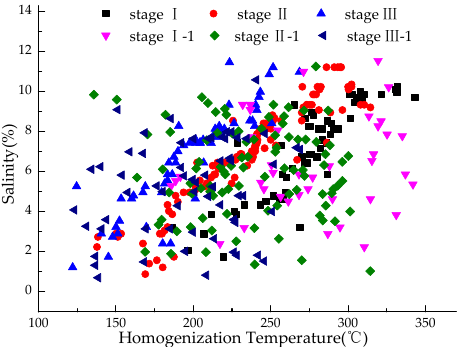
Figure 9. Diagram of temperature and salinity in Xiaojiashan gold deposit. The data of Stages I-1, II-1 and III-1 are from [30].